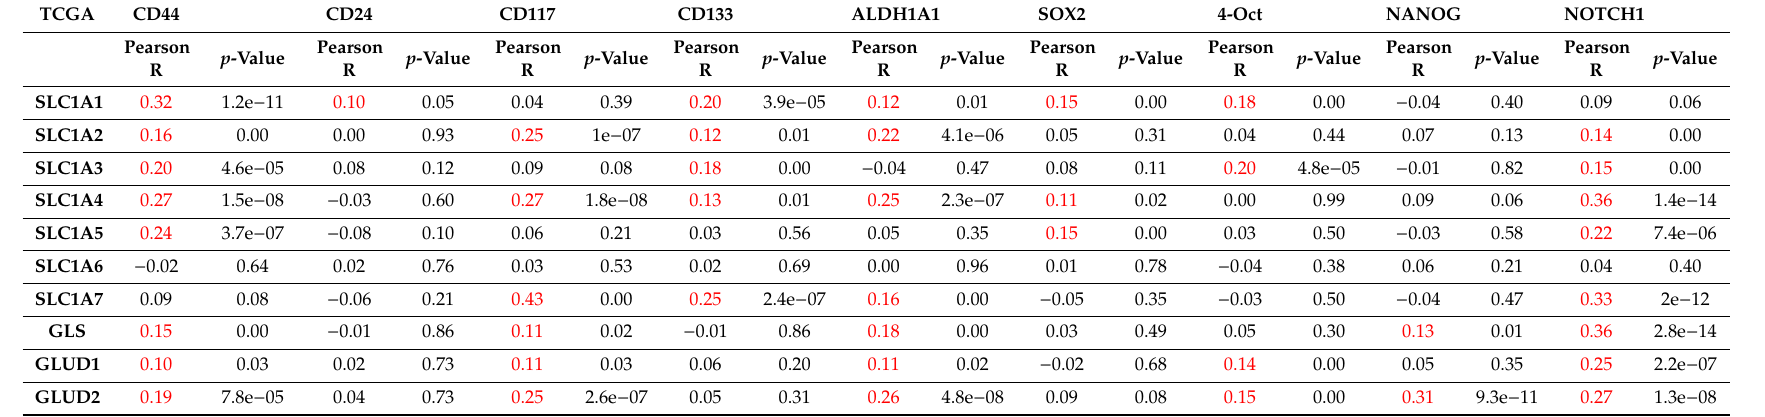
Table 5. Correlation between OCSC markers and glutamate transporters and key enzymes in glutamate / glutamine metabolism in TCGA. Red indicates significant positive and black indicates insignificant p -values of either positive or negative